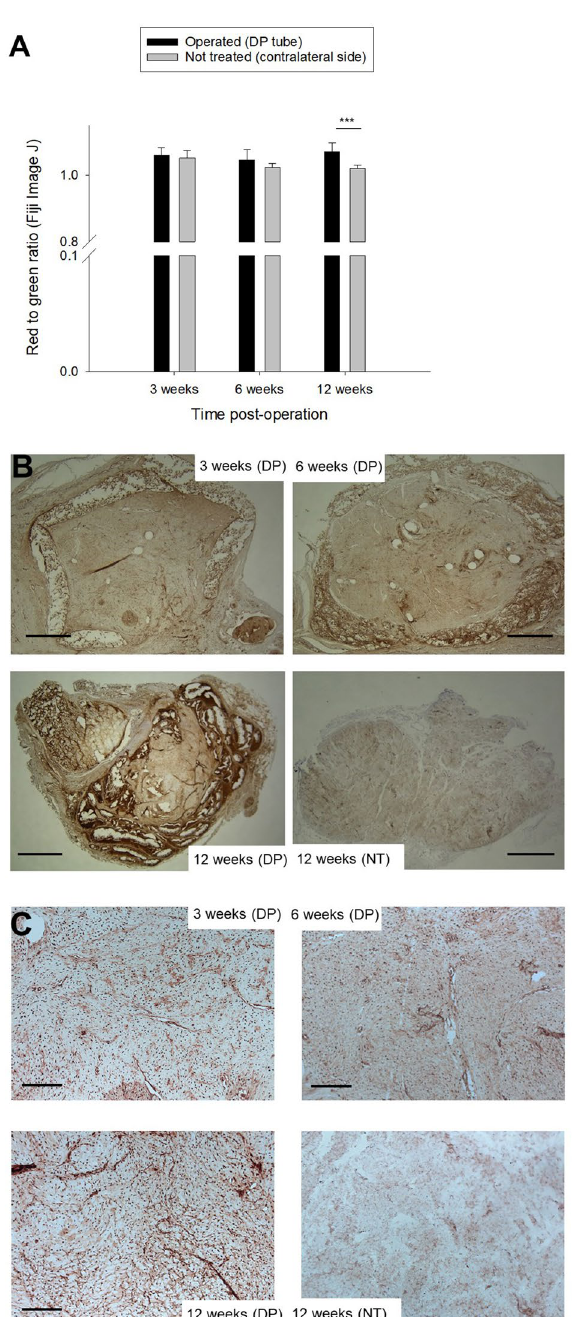
Figure 3. PAR-2 protein expression in DP treated tendon sections (n = 3) compared to contralateral side (no treatment; n = 3); quantified by the red/green ratio in histograms with 5 FOVs per section ( A ) and representative samples stained for PAR-2 ( B ), with areas of higher magnification, taken from the middle of the AT ( C ). The dark brown staining at 12 weeks does not come from an overexpression of PAR-2 by the tenocytes; it is the partially degraded DegraPol polymer that stains like this (Supporting Information SI Fig. 3). Nevertheless, the mid portion of the AT showed a significant slight increase in PAR-2 expression (+ 4.9%). Scale bars indicate 500 µm; in inserts they indicate 100 µm. Stars, with p-values, indicate pairwise comparison probability: p < 0.05 (*), p < 0.01 (**) and p < 0.001